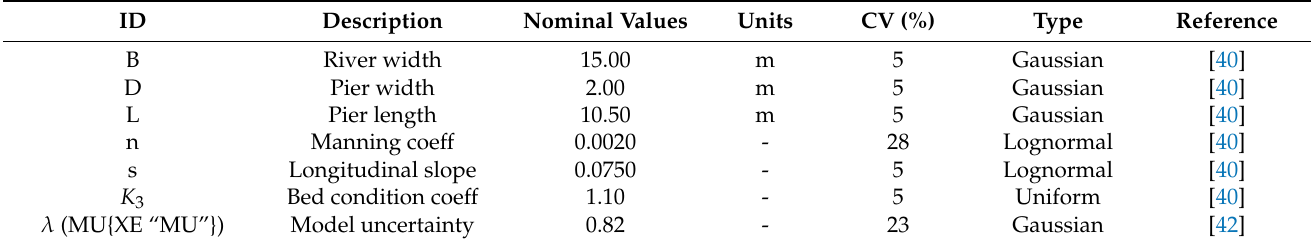
Table 1. Random variables for the scour analysis.